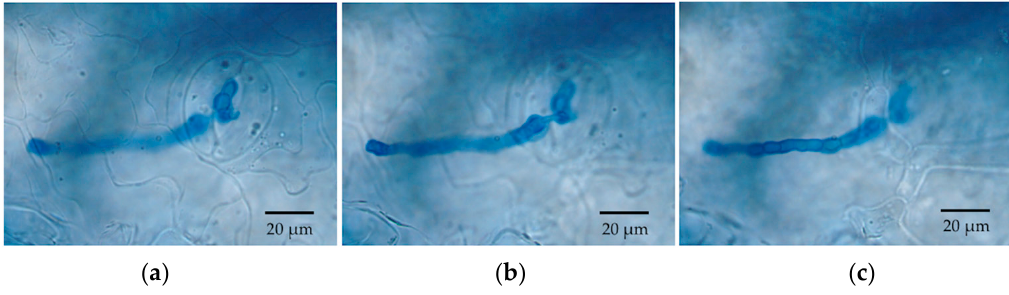
Figure 4. Cladosporium hypha entering a stoma of a leaf disc of P. trichocarpa . ( a ) Focused on the leaf epidermis; ( b ) Focused right below epidermis; ( c ) Focused within deeper leaf tissue.